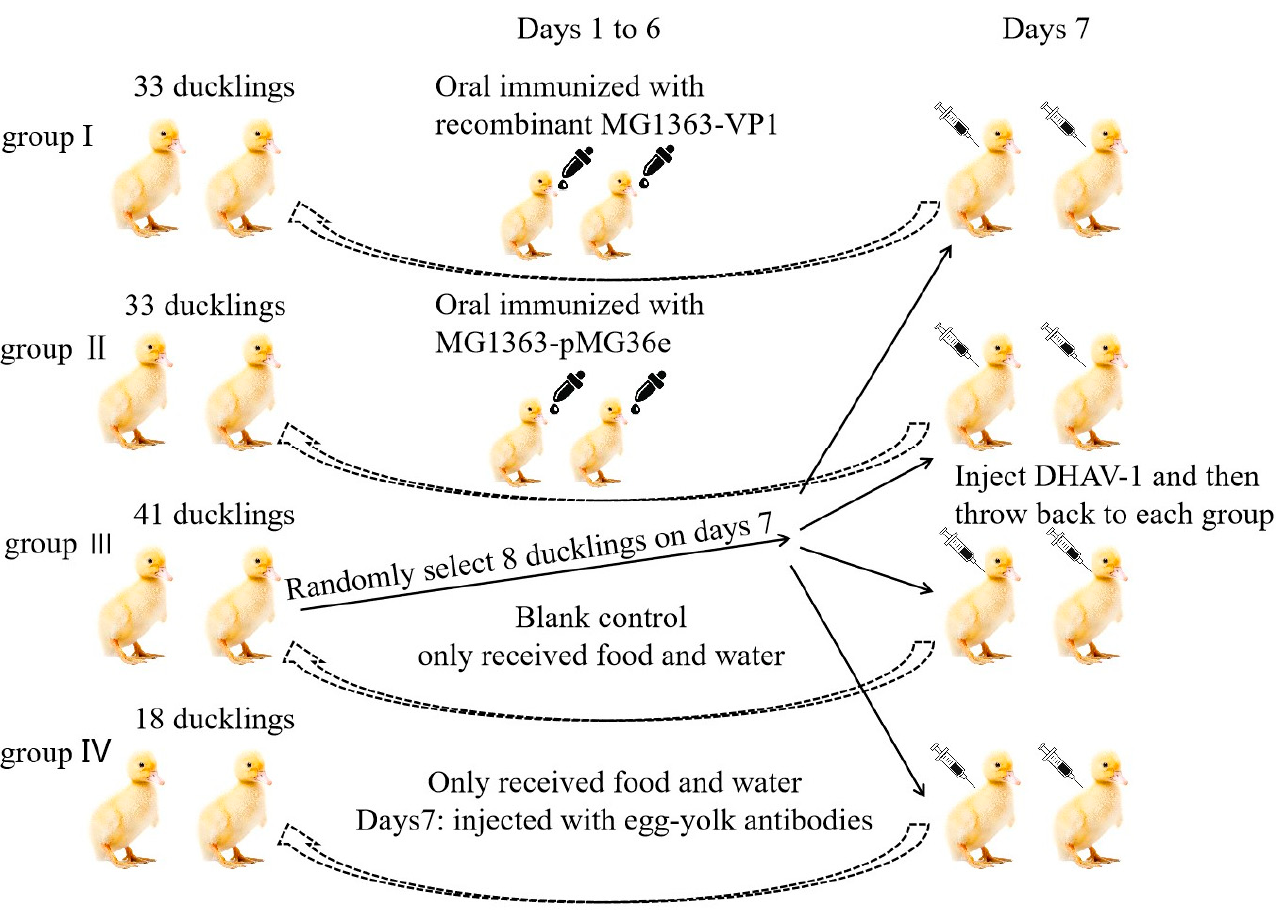
Figure 2. Oral vaccination experiment in ducklings. A total of 125 one-day-old ducklings were randomly divided into four groups, named group I (MG1363-VP1, 33 ducklings), group II (MG1363-pMG36e, 33 ducklings), group III (blank control group, 41 ducklings), and group IV (egg-yolk antibody group, 33 ducklings).